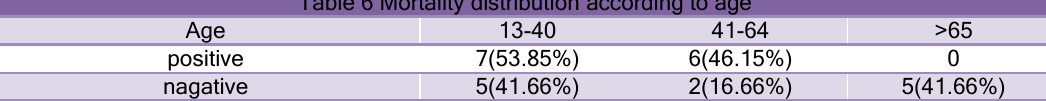
Table 6 Mortality distribution according to